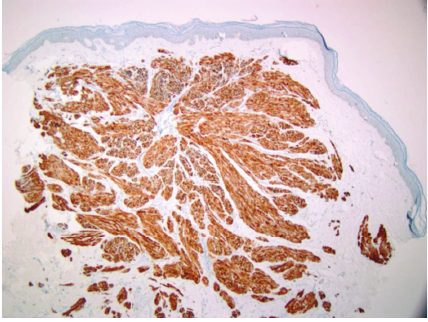
Figure 3: Desmin immunohistochemistry